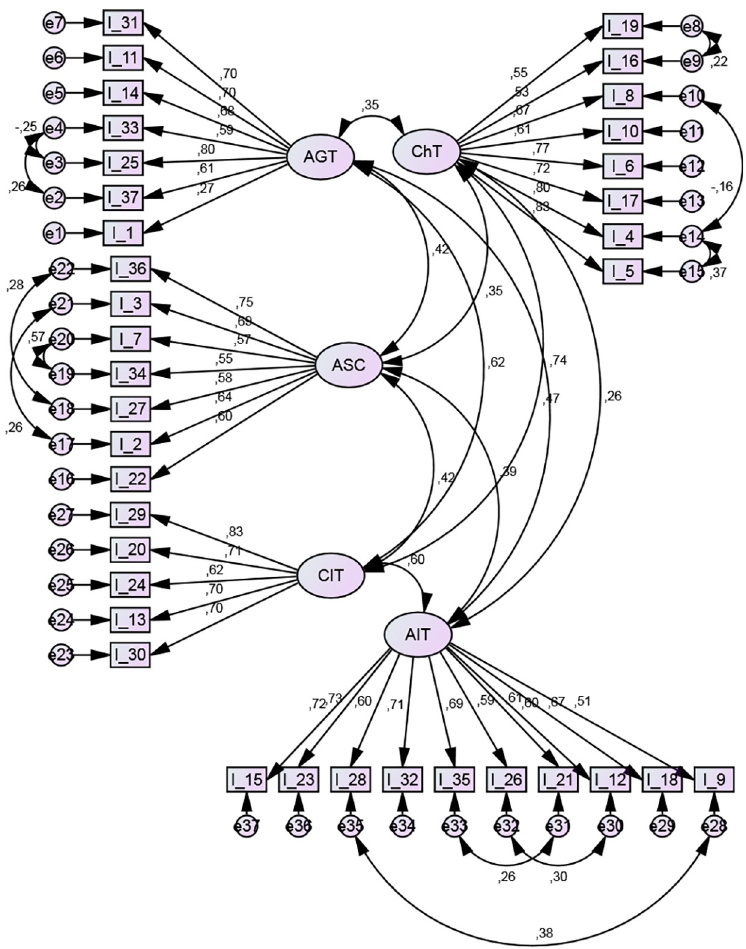
Fig 2. CFA Path diagram for Model 2 of the TEAQ-37 Rus. Rectangles indicate measured variables and large ellipses represent TEAQ-37 Rus subscales. Covariances of errors between items with similar content are shown.